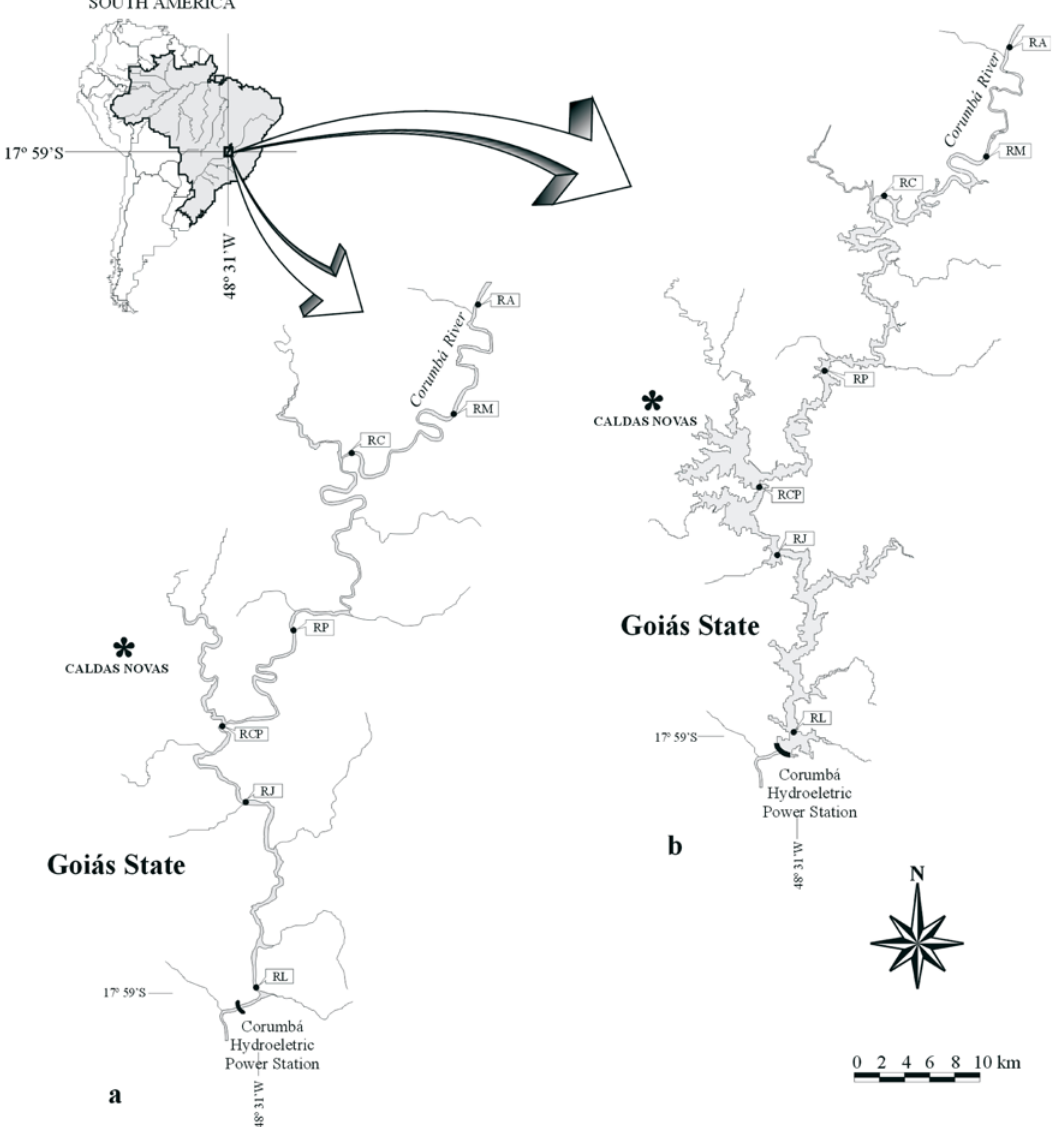
Fig. 1. Location of the study area in the rio Corumbá (a) and reservatório de Corumbá (b),